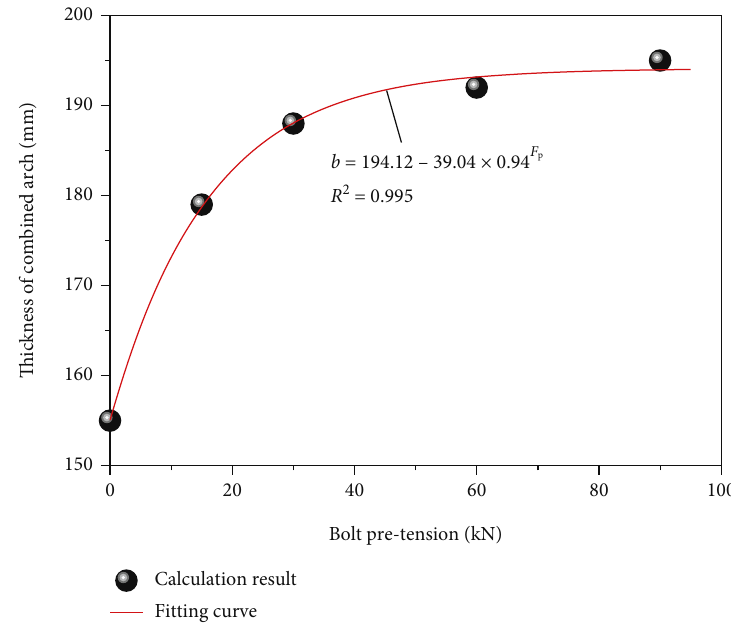
Figure 13: E ff ect of pretightening force on the thickness of combined